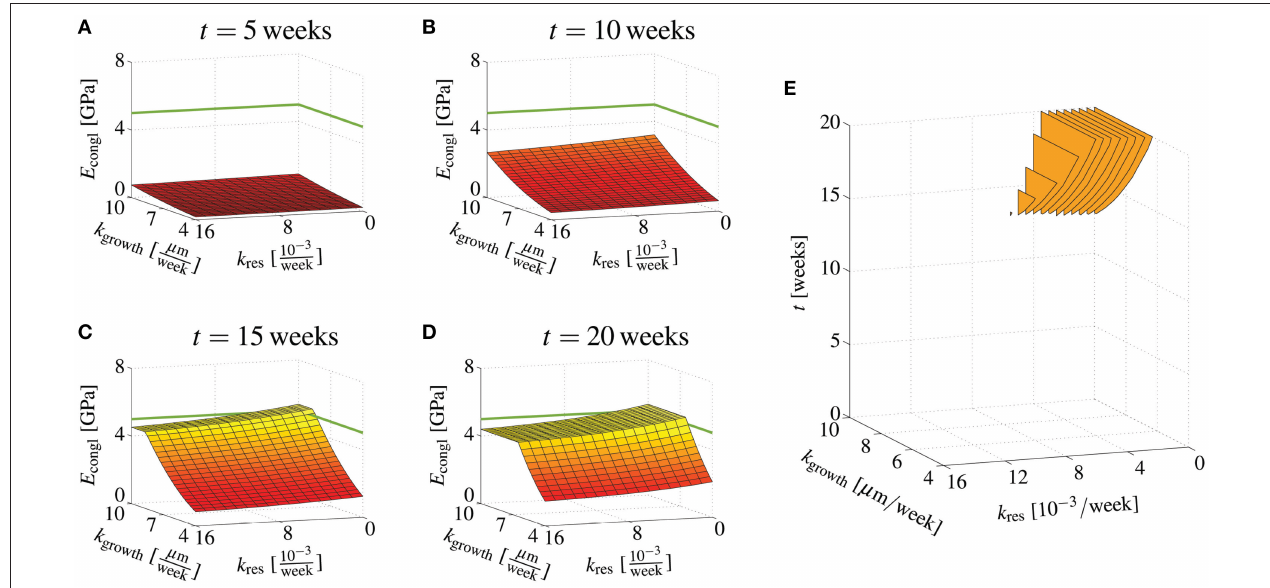
FIGURE 7 | Effects of bone regeneration kinetics parameters on the overall conglomerate stiffness at distinct time points. Young’s modulus of the macroscopic scaffold material for ǫ (A) 5 days, (B) 10 days, (C) 15 days, and (D) 20 days; (E) illustration when certain combinations of k res and k form yield 5GPa